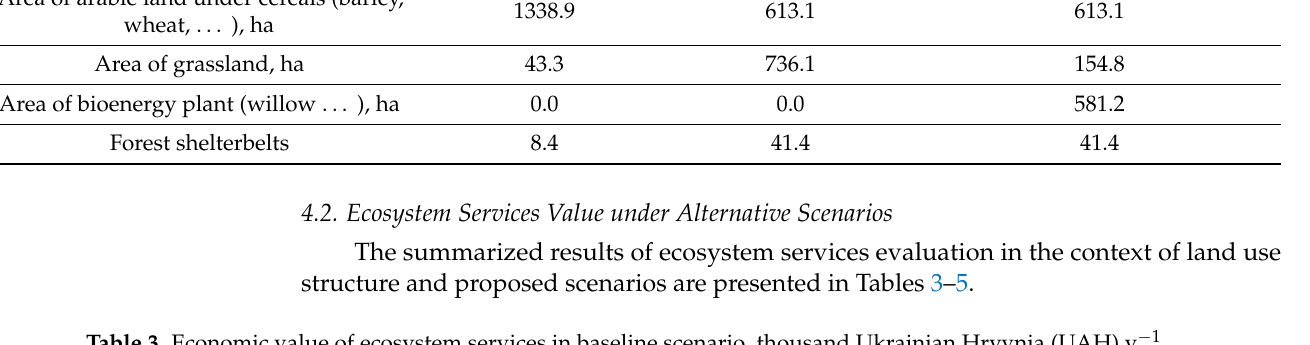
Table 3. Economic value of ecosystem services in baseline scenario, thousand Ukrainian Hryvnia (UAH) y − 1 . Ecosystem Services